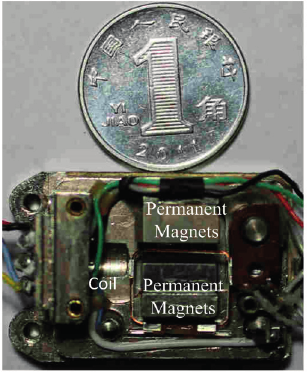
Figure 1. Schematic view of the Wire Suspended Micro-Pendulum Accelerometer.